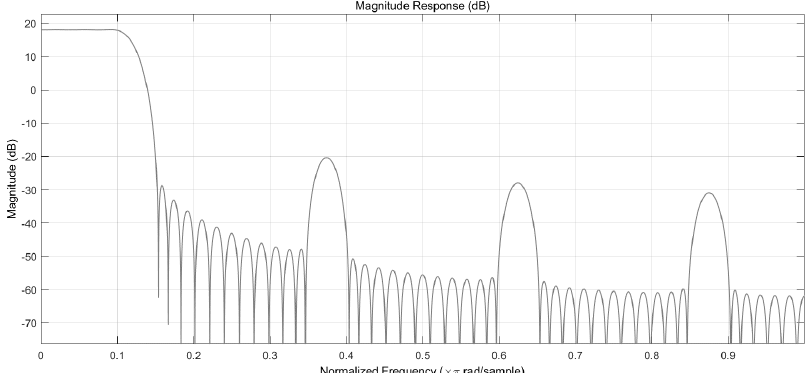
Figure 9. ( a ) The resampling spectrum when the interpolation factor of sinc is 8 and the filter pa- rameter is 6; ( b ) Resampled time domain waveform with 8× interpolation and a filter factor of 6. Figure 10. The filter frequency response when the interpolation multiplier of sinc is 8 and the filter parameter is 6.